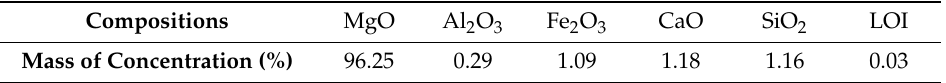
Table 3. Chemical compositions of MgO.